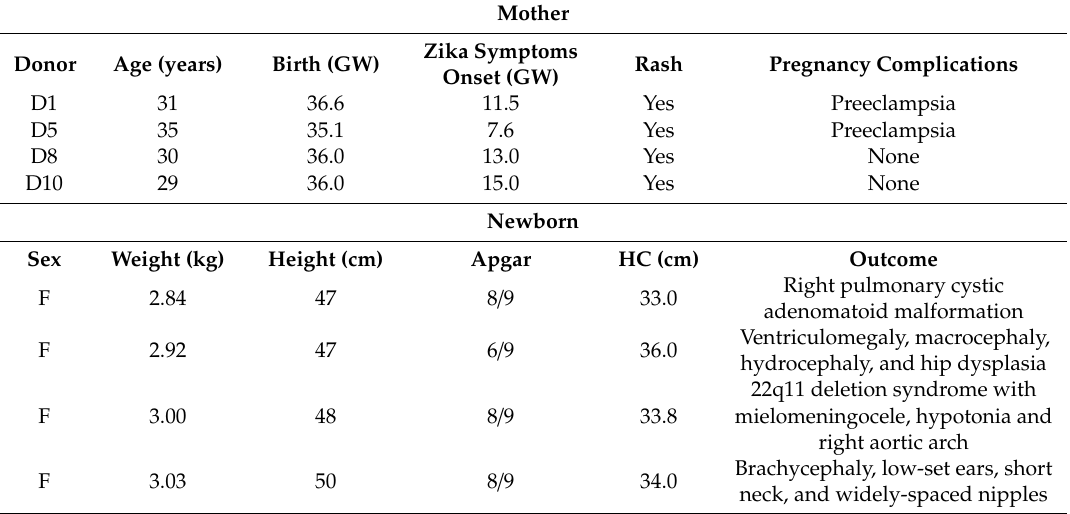
Table 1. Clinical data of women with ZIKV during pregnancy and physical findings of their newborns.